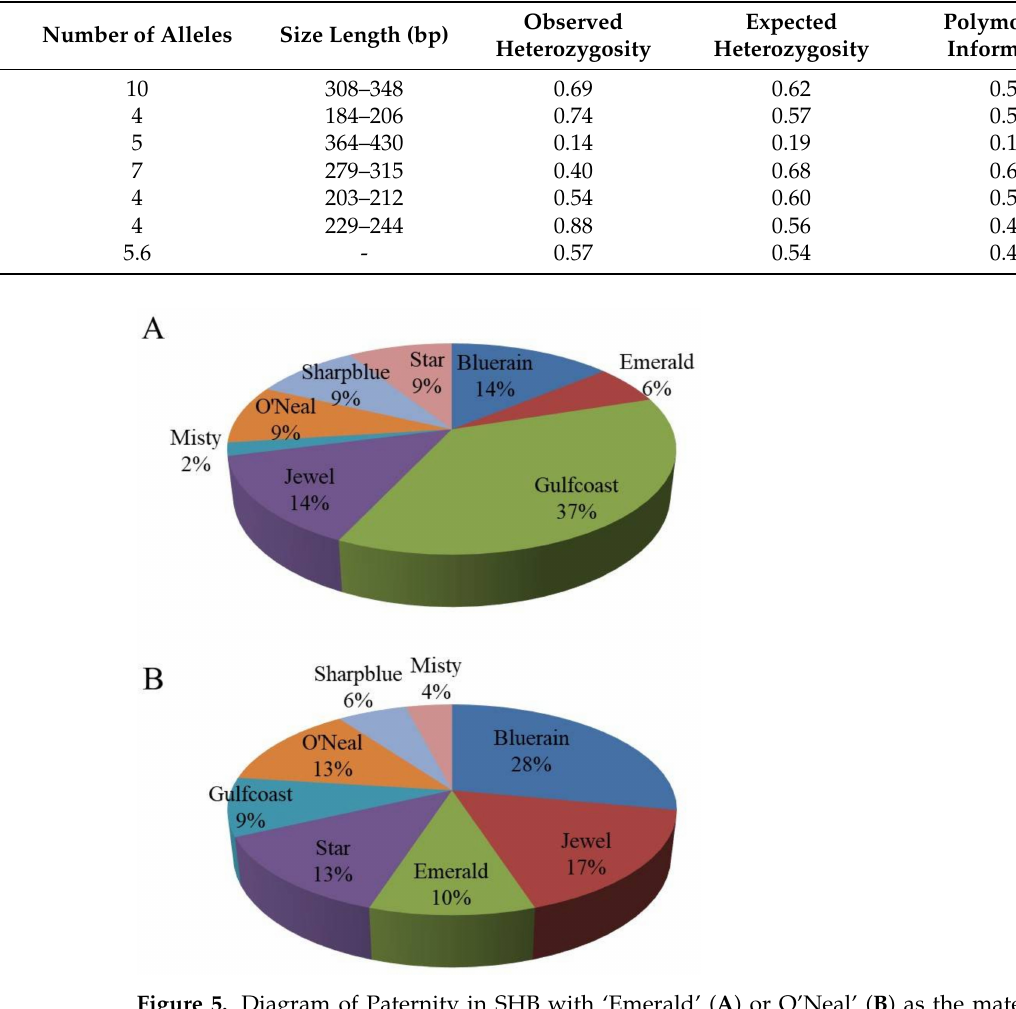
Table 4. Diversity statistics based on six SSR makers in SHB resulting from cross pollinations.